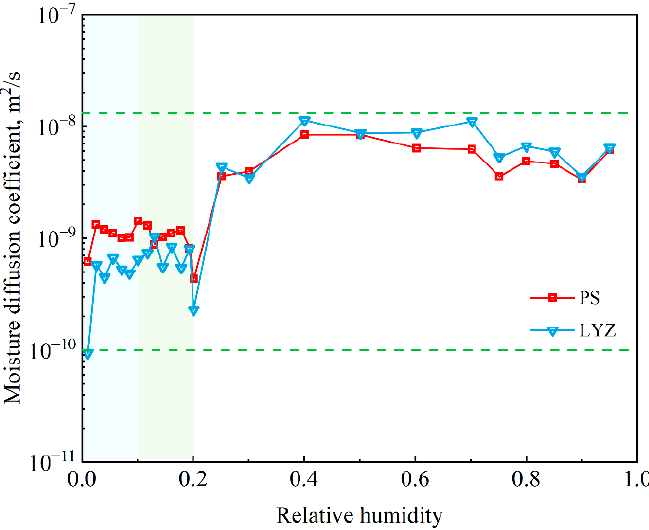
Figure 9. The water vapor diffusion coefficient variation in coal pore fissure under different relative humidity.